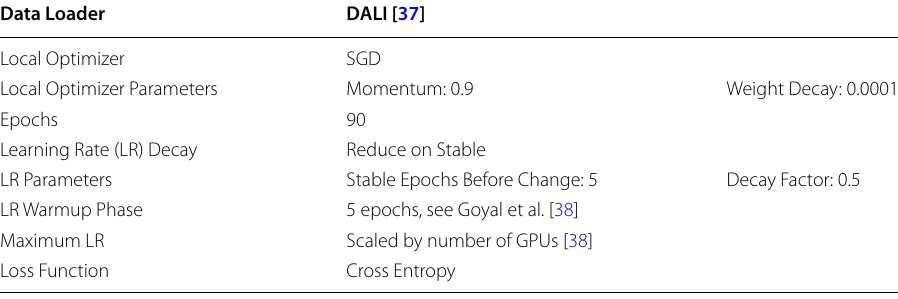
Table 1 Hyperparameters used to train ResNet-50 using the ImageNet-2012